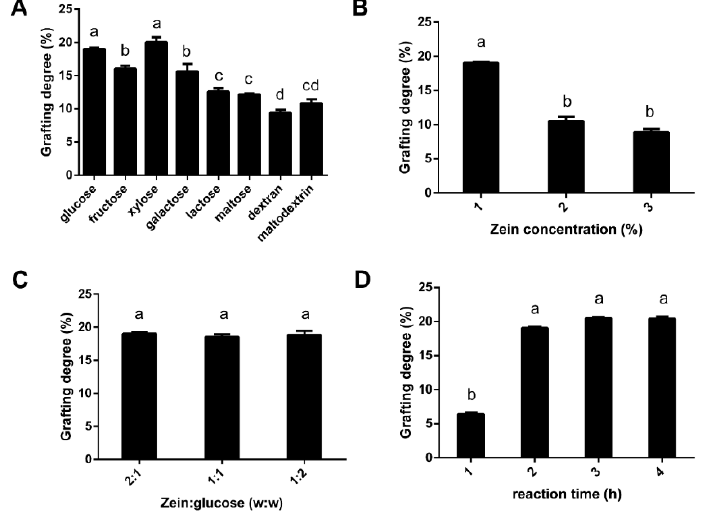
Figure 1. Effects of ( A ) sugar type, ( B ) zein concentration, ( C ) the mass ratio of zein to sugar, and ( D ) reaction time on the grafting degree of zein. Values are presented as the mean ± SD. Different letters represent significant differences ( p < 0.05) in grafting degree.